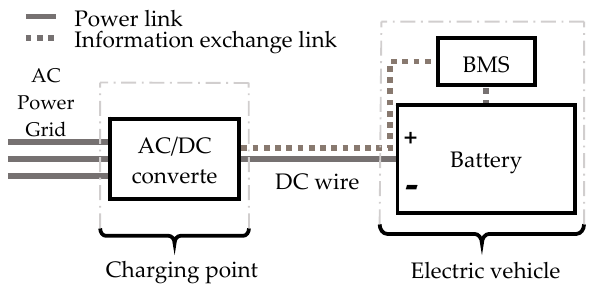
Figure 2. Information exchange and power flow chart between fast charging point and electric ve- hicle.